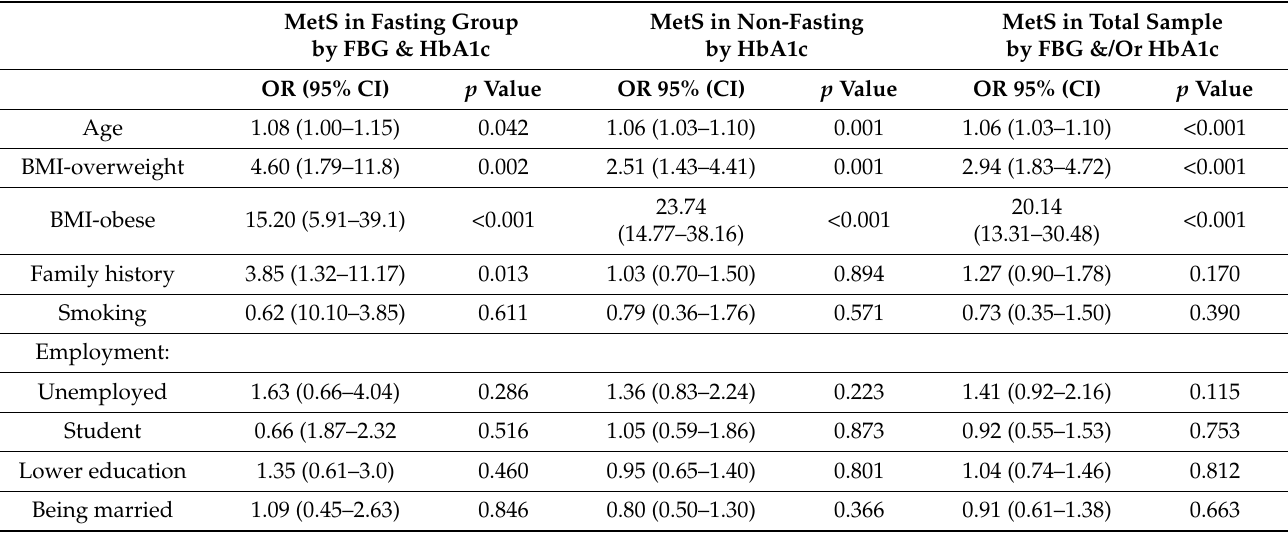
Table 6. Multivariate logistic regression analysis